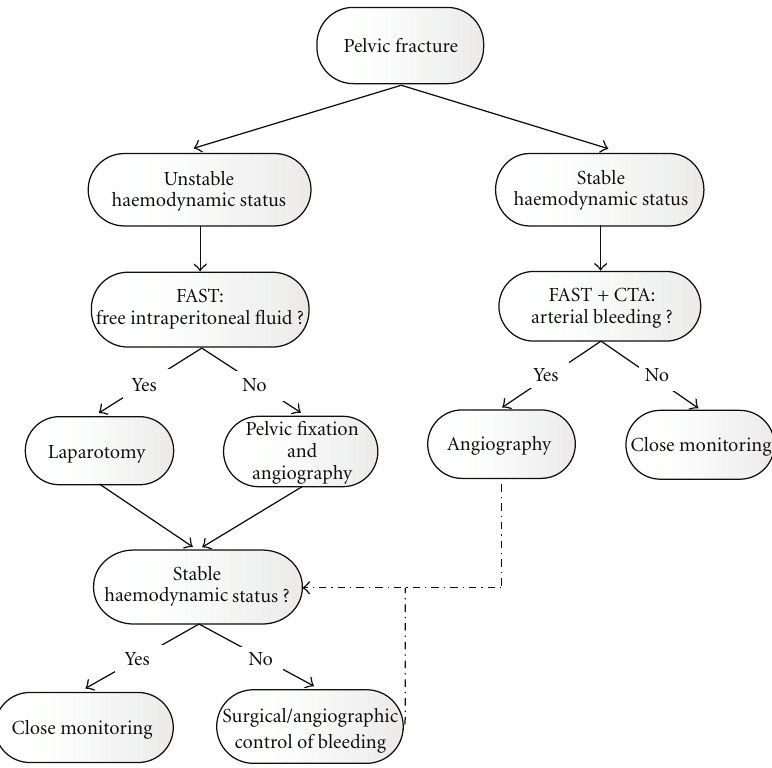
Figure 2: Treatment algorithm. FAST: focused assessment with sonography for trauma; CTA: computed tomography angiography.